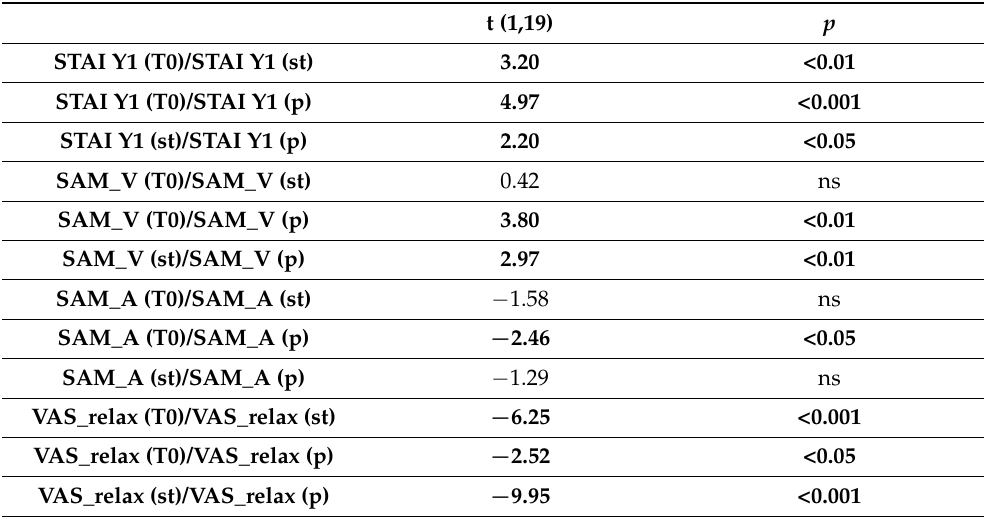
Table 5. Paired Samples t -test between psychological constructs administered at three different